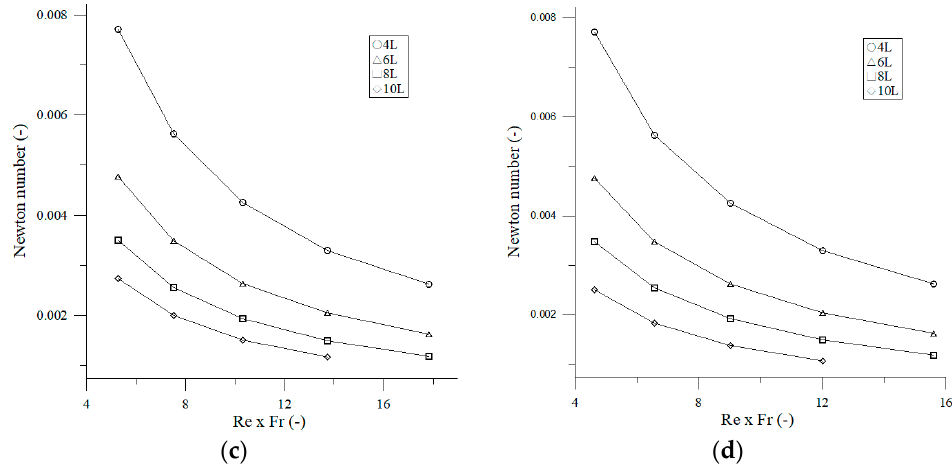
Figure 4. Relationship between Newton number and the product (Re x Fr) of different filling volumes. ( a ) Water; ( b ) 5 vol% glycerin; ( c ) 10 vol% glycerin; ( d ) 20 vol%